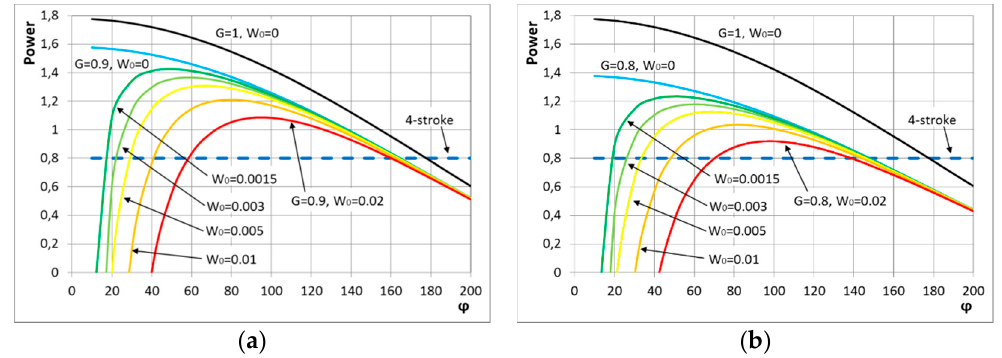
Figure 3. Calculated power or torque [Equation (3)] of the proposed 2-stroke design with poppet valves, with respect to a 4-stroke with the same displacement. Besides the mechanically pre-adjusted ϕ , the referential pumping work W 0 and the scavenging efficiency G largely determine a potential gain or loss. ( a ) G = 0.9. ( b ) G = 0.8.